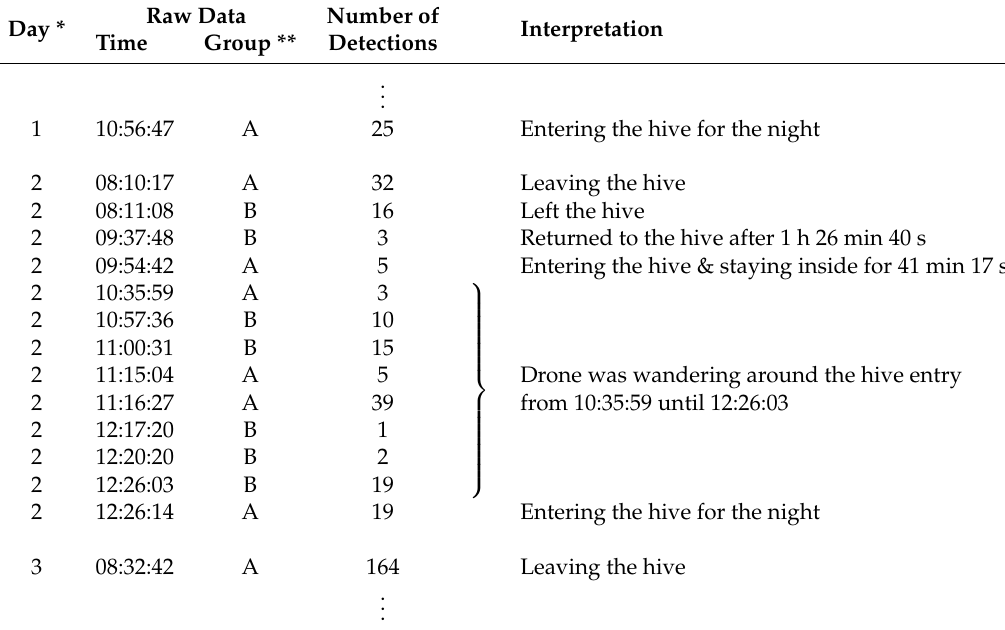
Table 6. Data sample illustrating the activity of a single drone from Argentina in a day, including an interpretation of events associated to this bee’s activity. The data interpretation is subject to the user experience, which should also consider the experiment protocol adopted. Last data of the previous day and the first data of the next day are also